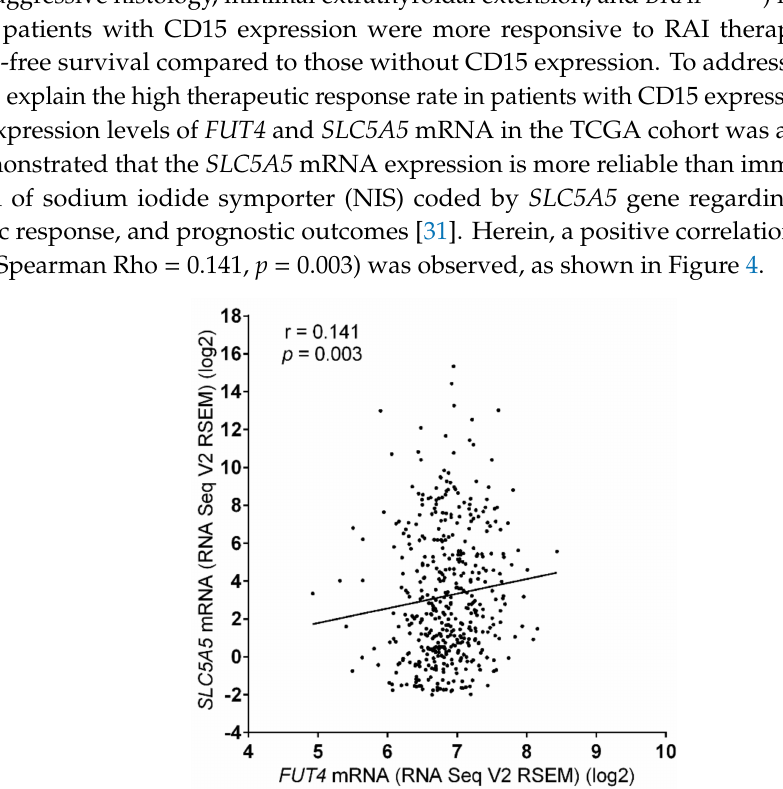
Figure 4. Correlation between mRNA expression of FUT4 and SLC5A5 in the TCGA